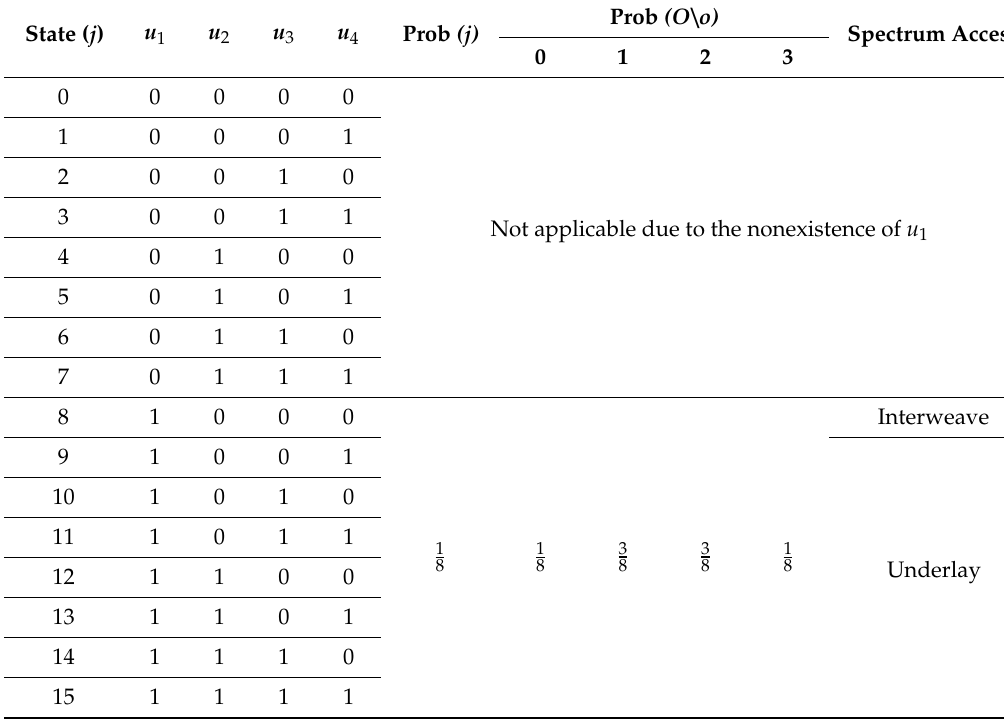
Table 1. Co-existence and probability distribution for the UE u 1 of MNO 1 with UEs u 2 , u 3 , and u 4 of other MNOs O \ o in an